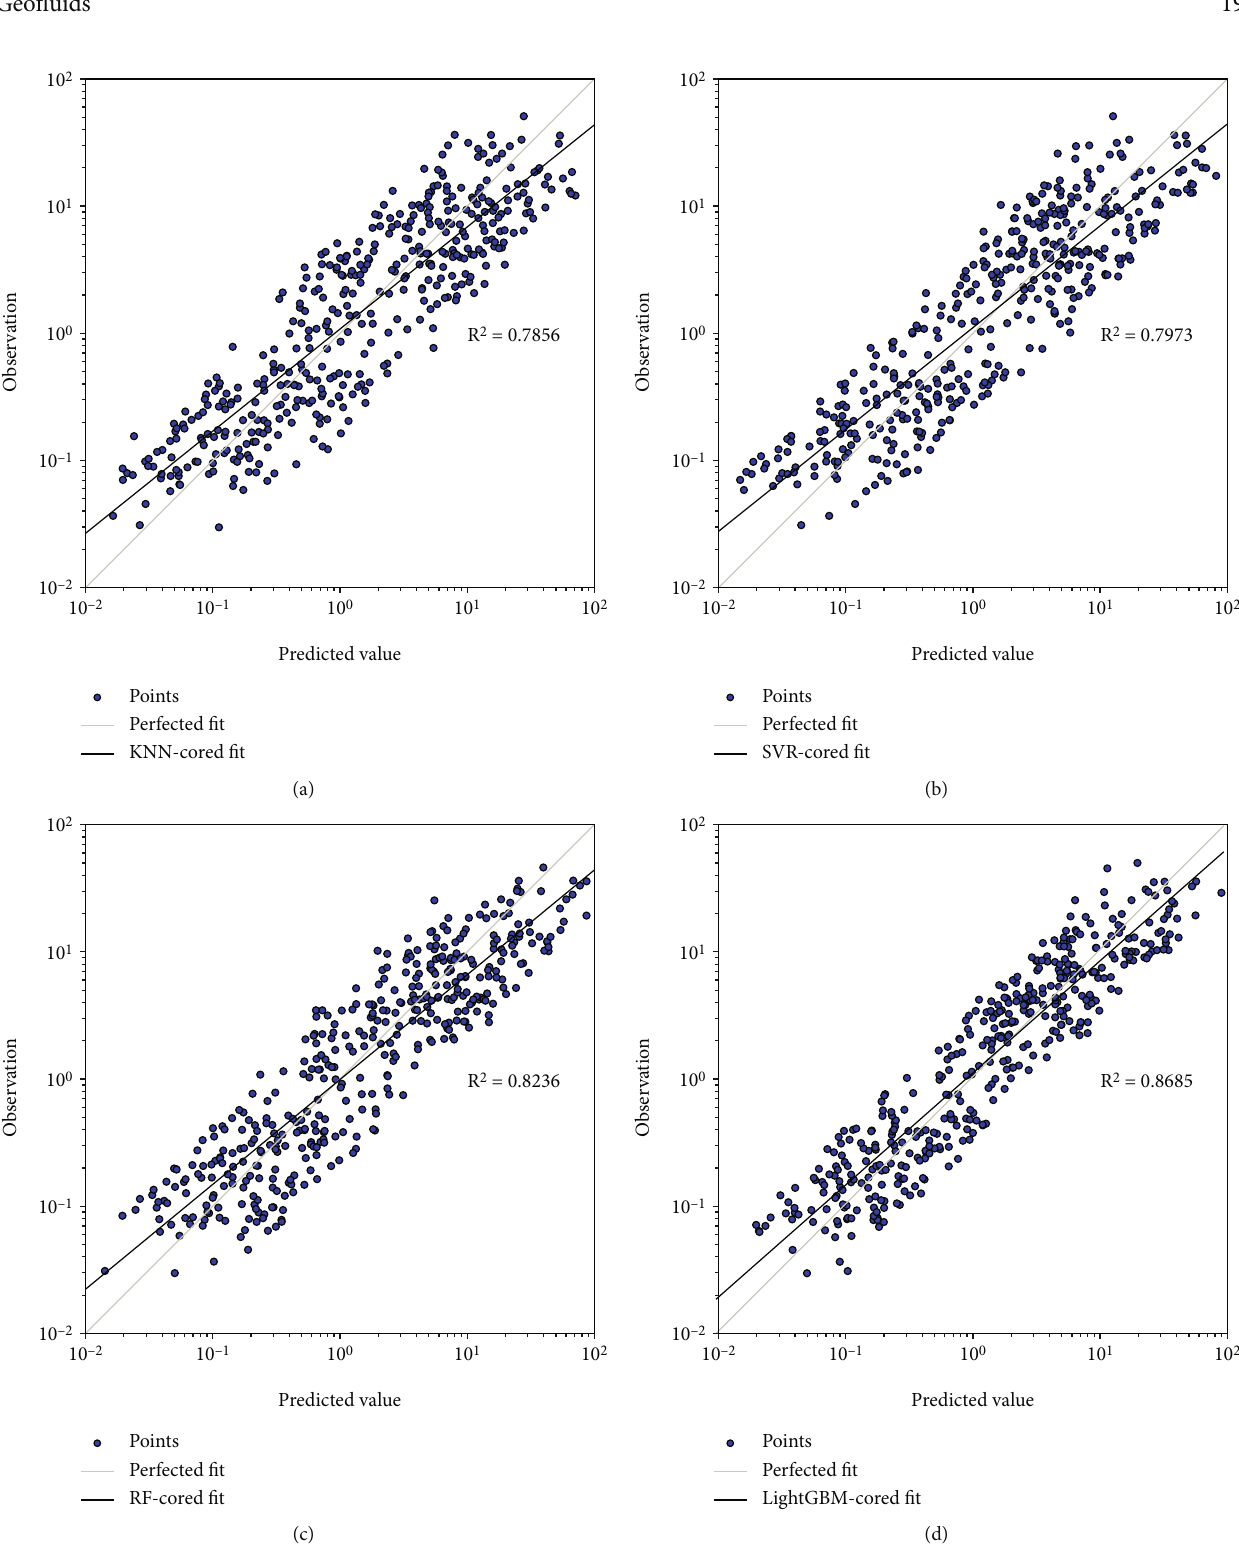
Figure 10: Fitness of permeability results provided by KNN-cored predictor (a), SVR-cored predictor (b), RF-cored predictor (c), and LightGBM-cored predictor (d) in the fi rst experiment. KNN =k-nearest neighbors; SVR =support vector regression; RF=random forest; LightGBM=light gradient boosting machine; RMSE =root-mean-square